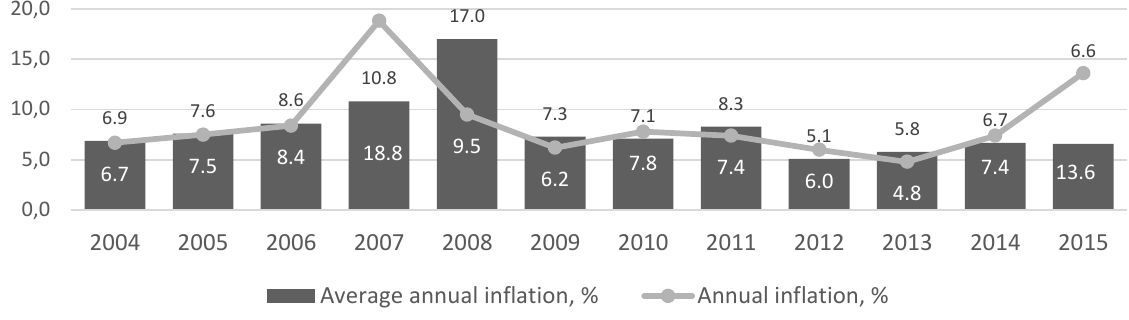
Figure 2. Inflation assessment in 2004‒2015